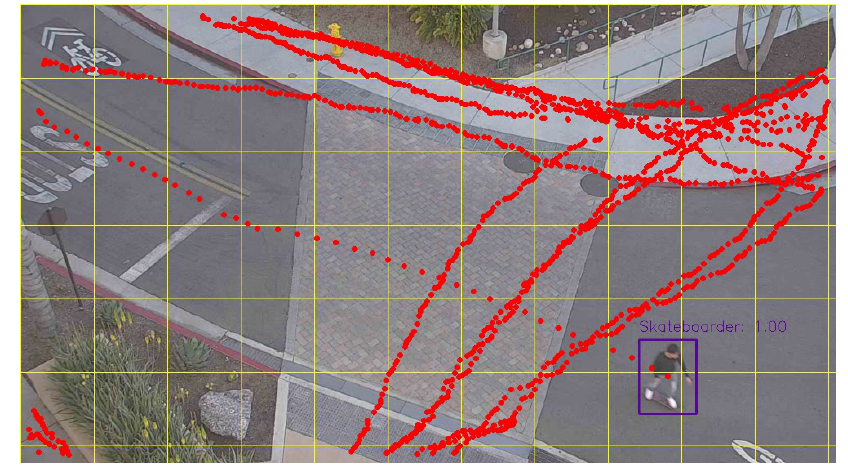
Figure 30. Object detection model drawing contrails of skateboarders